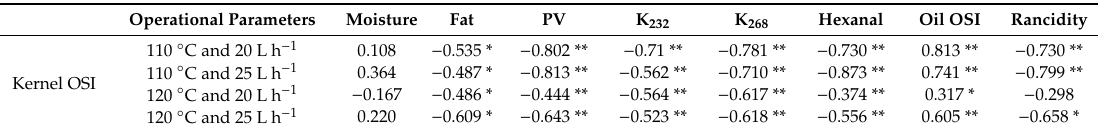
Table 3. Correlations between kernel oxidative stability index (kernel OSI), quality and oxidative parameters of the walnut kernels and extracted